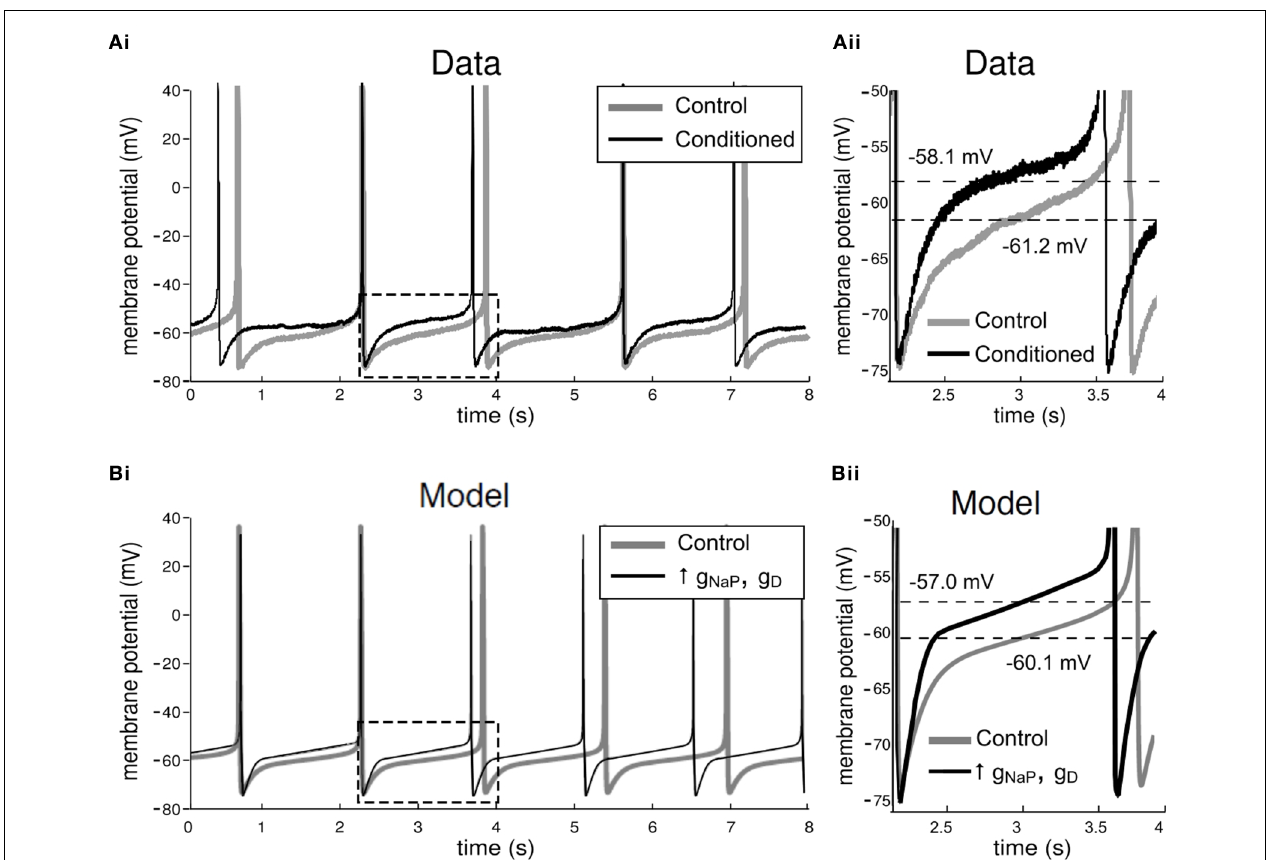
FIGURE 6 | Electrophysiological effects of conditioning in the biological and model CGCs. (A) Effects of conditioning in the biological CGCs. Recordings from CGCs in animals trained using a single-trial classical appetitive conditioning protocol do not show any signifi cant differences in the frequency of the spontaneous fi ring activity of the cell, when compared to recordings from cells in non-conditioned animals (Example traces shown in Ai, also see Kemenes et al., 2006). However, the membrane potential of CGCs from conditioned animals (measured midway between consecutive spikes and averaged for the whole trace shown) was depolarized, when compared to CGC recordings from non-conditioned control animals (section of Ai in dashed rectangle shown in Aii ).